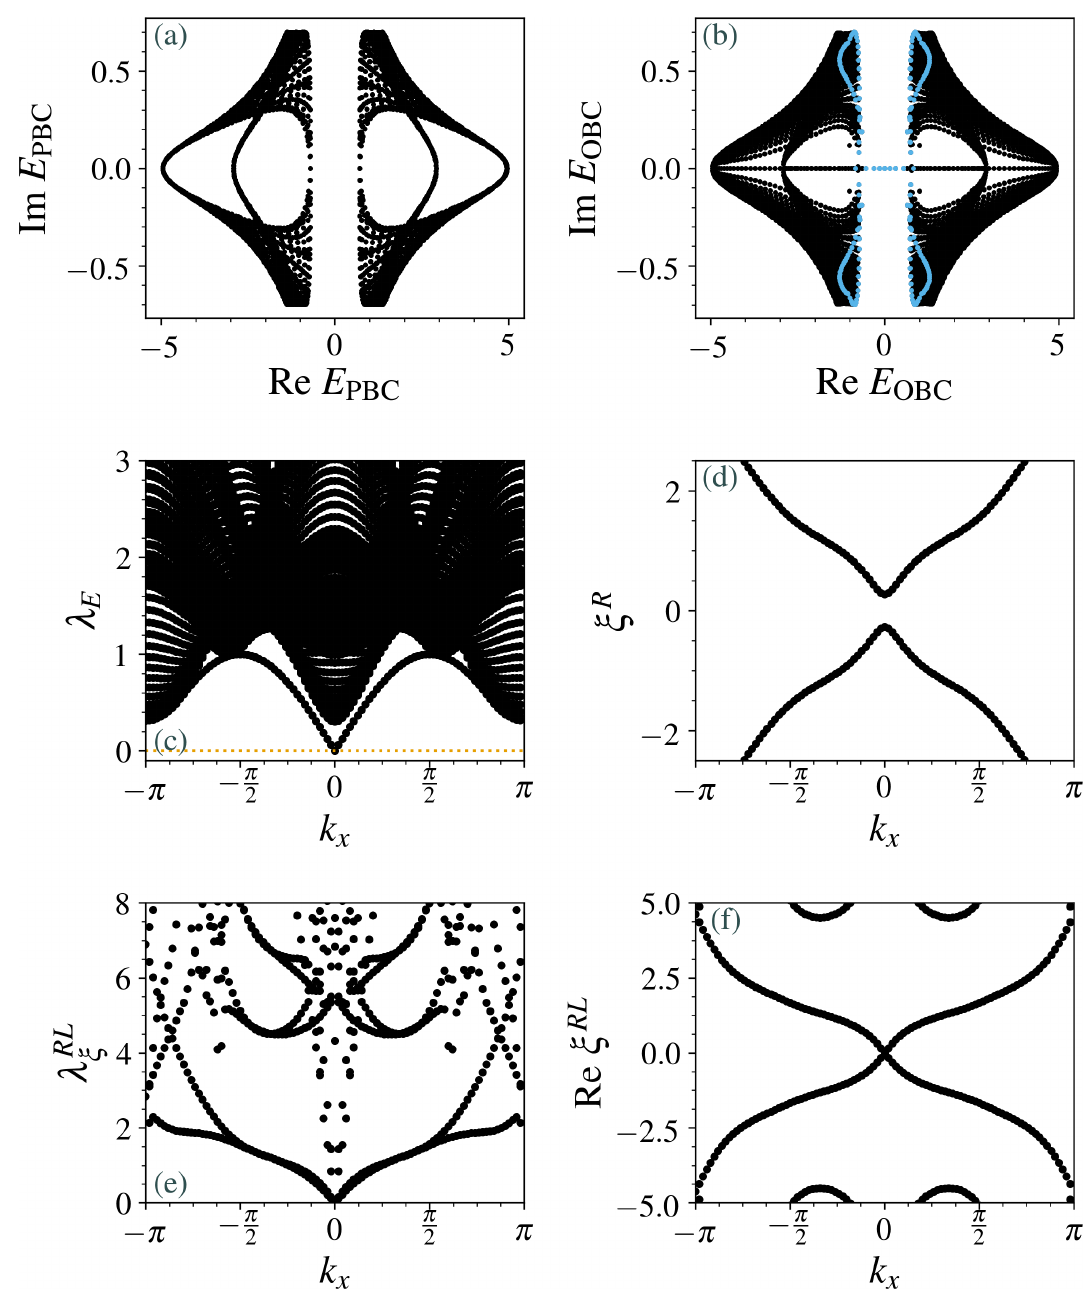
= t = 2, ∆ = ∆ = µ = 1 and γ = 0.7. (a) Energy spectrum Figure 11: We fix t x y x y of the model in Eq. (49) for periodic boundary conditions. (b) Energy spectrum on a cylinder geometry. The highlighted bands are the states with the lowest real part of the energy at each momentum k . The low-energy edge modes are stuck x on the real axis. (c) Singular value spectrum of the OBC model. Two chiral zero singular modes appear at each edge and are topologically protected. The dotted orange line is a guide to the eye. (d) Entanglement spectrum of the right density matrix: the edge modes are not protected and become gapped (e) Singular values of the biorthogonal entanglement Hamiltonian. (f) Real part of the biorthogonal entanglement Hamiltonian. In (e-f), we observe the same low energy edge modes as in the open